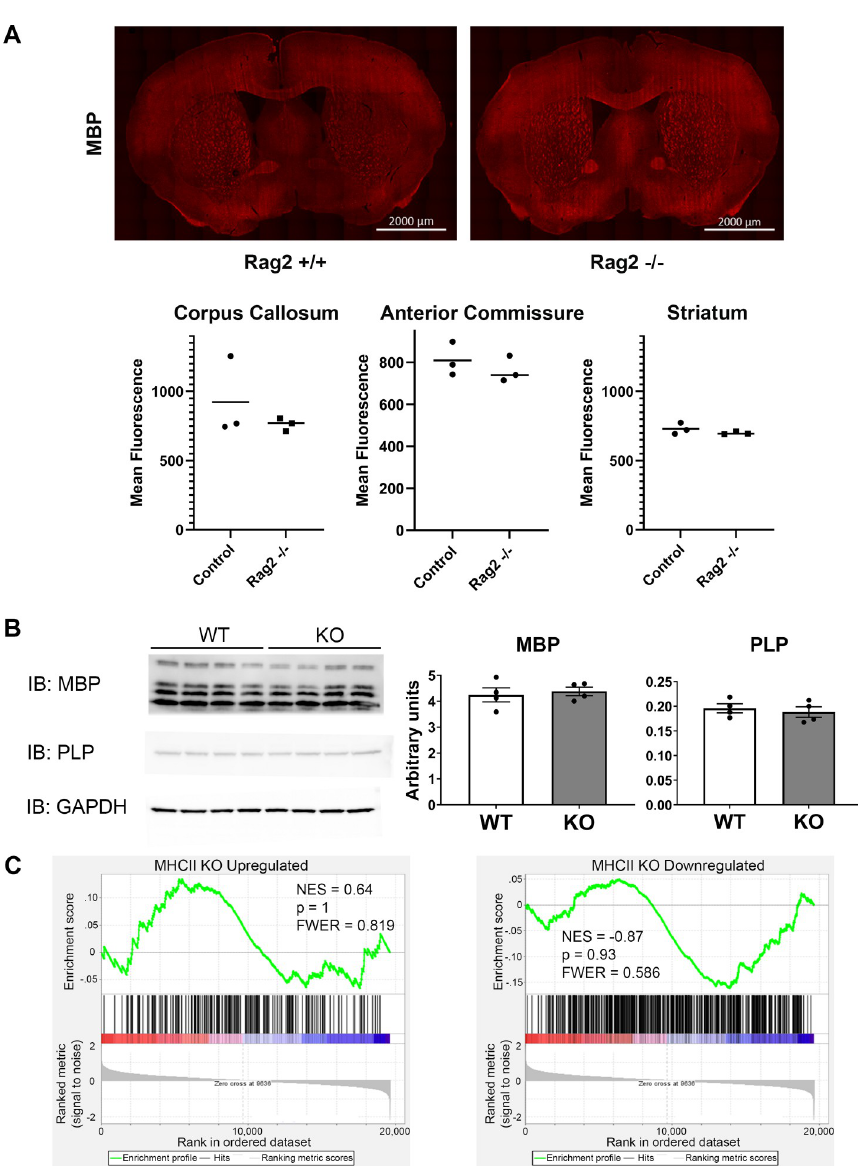
Fig 3. Normal myelin proteins and microglial gene signature in Rag2 -/- mice. A) Immunostaining of MBP. Top: representative images of MBP immunofluorescence in control (left) and Rag2 -/- (right) mice. Bottom: quantification of MBP fluorescence in 3 myelin rich regions; no significant differences. B) Western blots of key myelin proteins MBP and PLP. Left: Images of Western blot of MBP (top), PLP (middle), and reference protein GAPDH (bottom), Right: Quantification of signal intensity for MBP and PLP, normalized to GAPDH signal. No significant differences. All error bars = SEM. C) GSEA output of genes upregulated (left) or downregulated (right) in MHCII KO microglia reported in Pasciuto 2020. Neither MHCII KO up- nor downregulated genes are significantly enriched in a comparison of Rag2 +/+ vs . Rag2 -/- microglia (p = 1, 0.93); NES = normalized enrichment score, FWER = family wise error